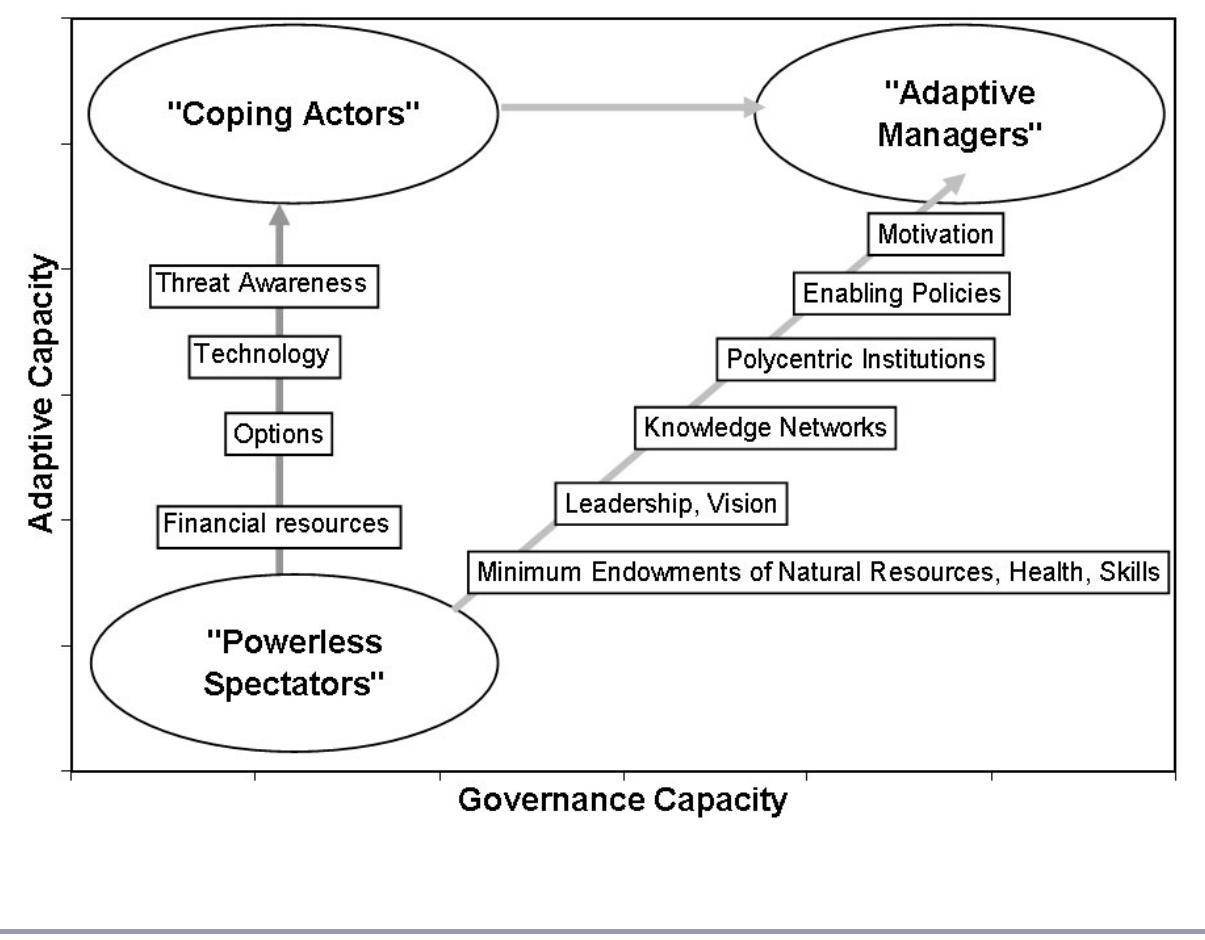
Fig. 1. Three types of adaptive communities along gradients of adaptive capacity and governance capacity, respectively. “Powerless spectator” communities have a low adaptive capacity and weak capacity to govern, do not have financial or technological options, and lack natural resources, skills, institutions, and networks. “Coping actor” communities have the capacity to adapt, but are not managing social–ecological systems. They lack the capacity for governance because of lack of leadership, of vision, and of motivation, and their responses are typically short term. “Adaptive manager” communities have both the capacity to adapt and the governance capacity to sustain and internalize this adaptation. They invest in the long-term management of ecosystem services. Such communities are not only aware of the threats, but also take appropriate action for long-term sustainability. Adaptive co-management becomes possible through leadership and vision, the formation of knowledge networks, the existence or development of polycentric institutions, establishing or maintaining links between culture and management, the existence of enabling policies, and high levels of motivation in all role